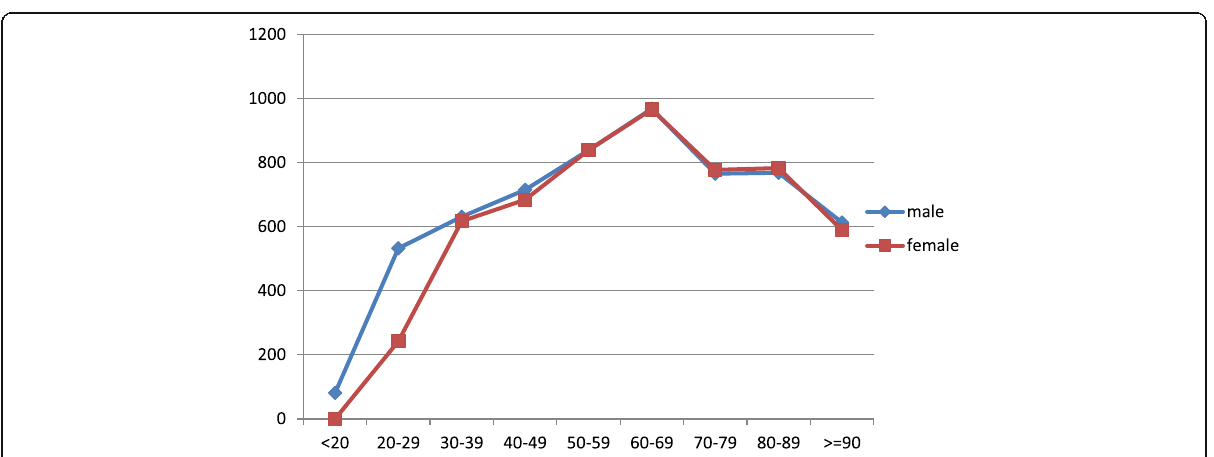
Fig. 3 It illustrates mean time in minutes from symptoms onset to hospital arrival for Males and females of different age groups